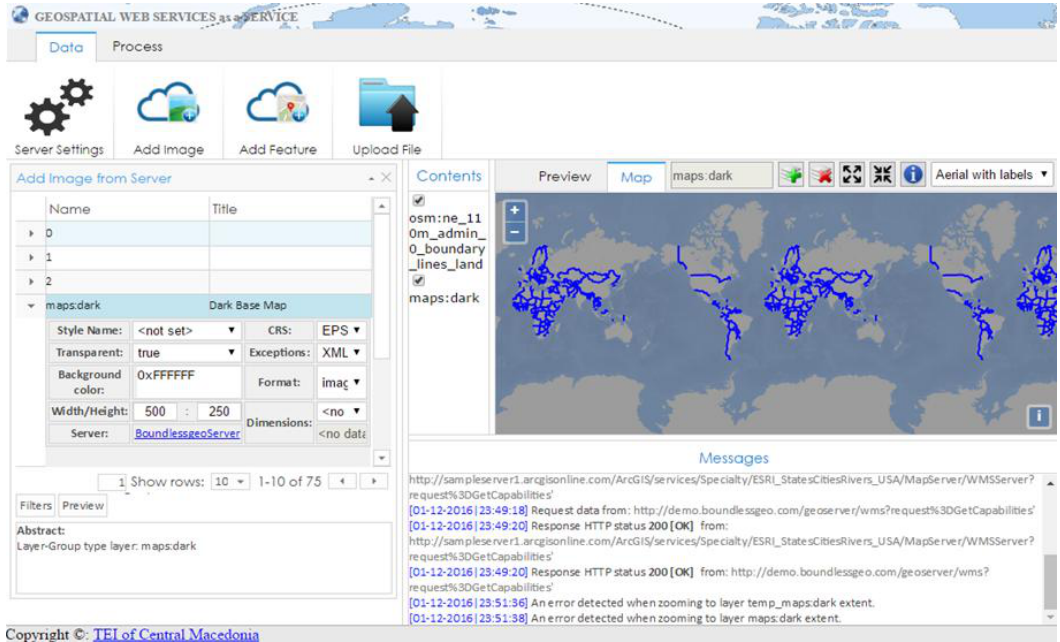
Figure 6. A Web interface implementing geospatial Web services.